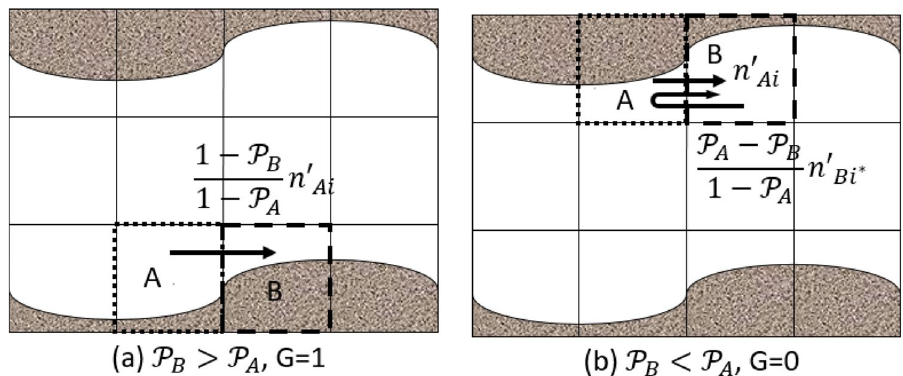
x (dashed) and upwind cell A Figure 3. Illustration of two streaming scenarios when the current cell B at (cid:31) x e i δ t are both boundary cells. A parameter G is introduced to distinguish these two cases. ( a ) (dotted) at � + � ∗ P B > P A , G = 1. The receiving particles are streamed from the upwind cell. Because the fluid fraction of B 1 P B n is smaller than that of cell A, only − ′ Ai particles of cell A can stream into cell B and no bounced-back 1 P A − particles. ( b ) P B < P A , G=0. The receiving particles consists of two parts: streamed from the upwind cell A P A P B n ( n ′ Ai ) and the bounced-back particles from the current cell − ′ Bi * in the opposite 1 P B −